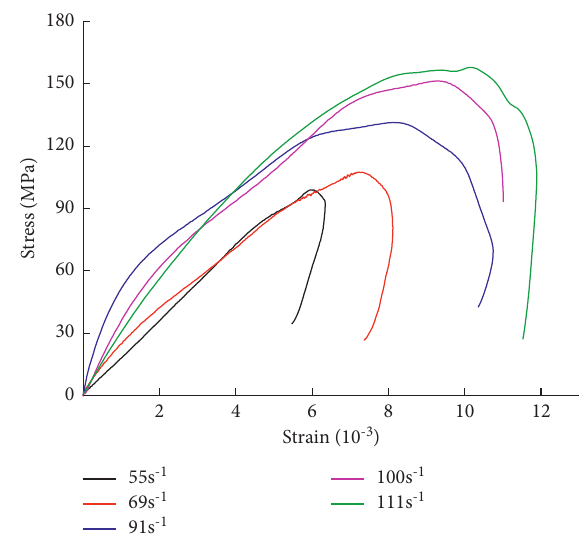
Figure 5: Stress-strain curve in different strain rates for